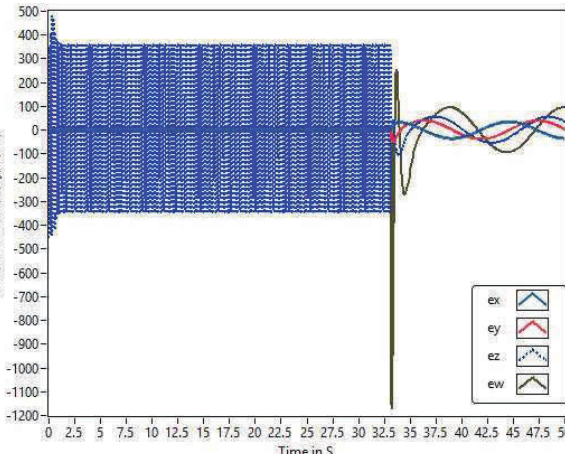
rived a new lemma to analyze the stability of the